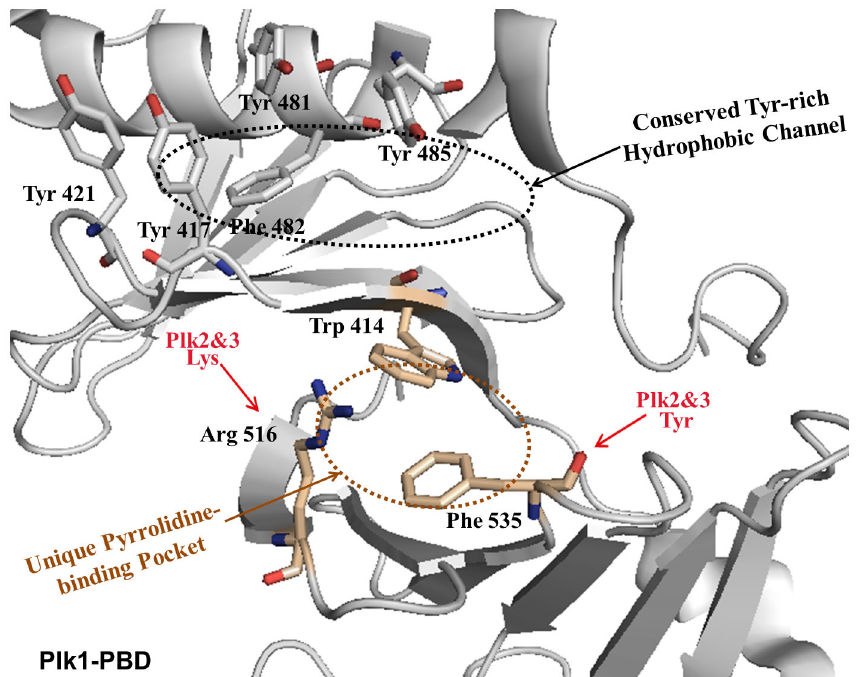
Figure 1. The crystal structure of the previously reported unligated Plk1 PBD, which shows the presence of both the unique pyrrolidine-binding pocket and conserved, Tyr-rich hydrophobic